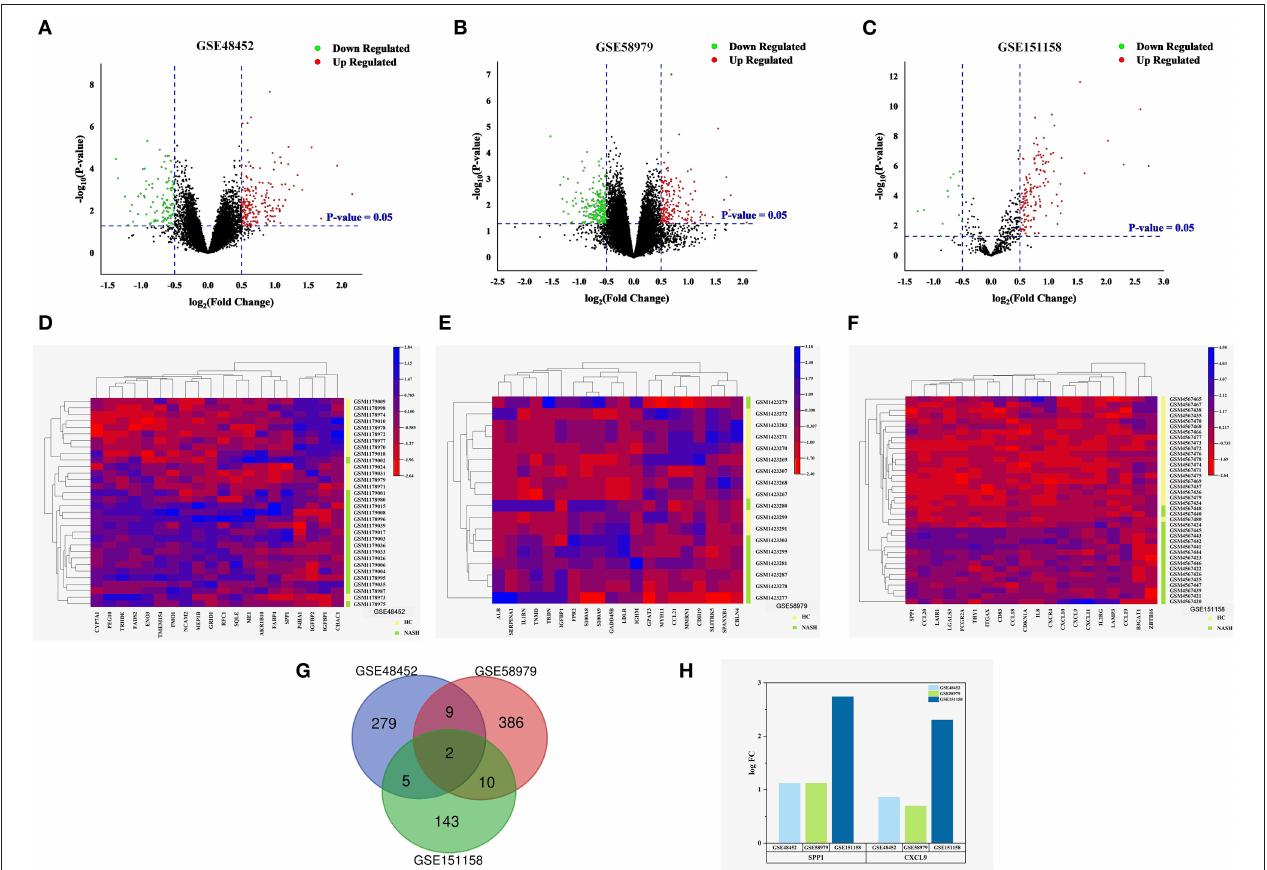
FIGURE 1 | Identification of DEGs in NASH. (A–C) Volcano plot of the differentially expressed genes of the three datasets. Red points indicate DEGs with a logFC > 0.5 and P < 0.05, green points indicate DEGs with a logFC < − 0.5 and P < 0.05. (A) GSE48452. (B) GSE58979. (C) GSE151158. (D–F) Heat map for the top 20 DEGs between NASH and normal liver tissues of the three datasets. Green lines represent NASH, and yellow lines represent HC. (D) GSE48452 (containing 18 NASH tissues and 14 normal liver tissues). (E) GSE58979 (8 NASH tissues and 10 normal liver tissues). (F) GSE151158 (17 NASH tissues and 21 normal liver tissues). (G,H) Venn diagram and the expression levels of the intersecting genes in GSE48452, GSE58979, and GSE151158. (G) Venn diagram displaying two DEGs present in both NASH and HC. (H) Expression levels of the intersecting genes (logFC = log Fold Change).